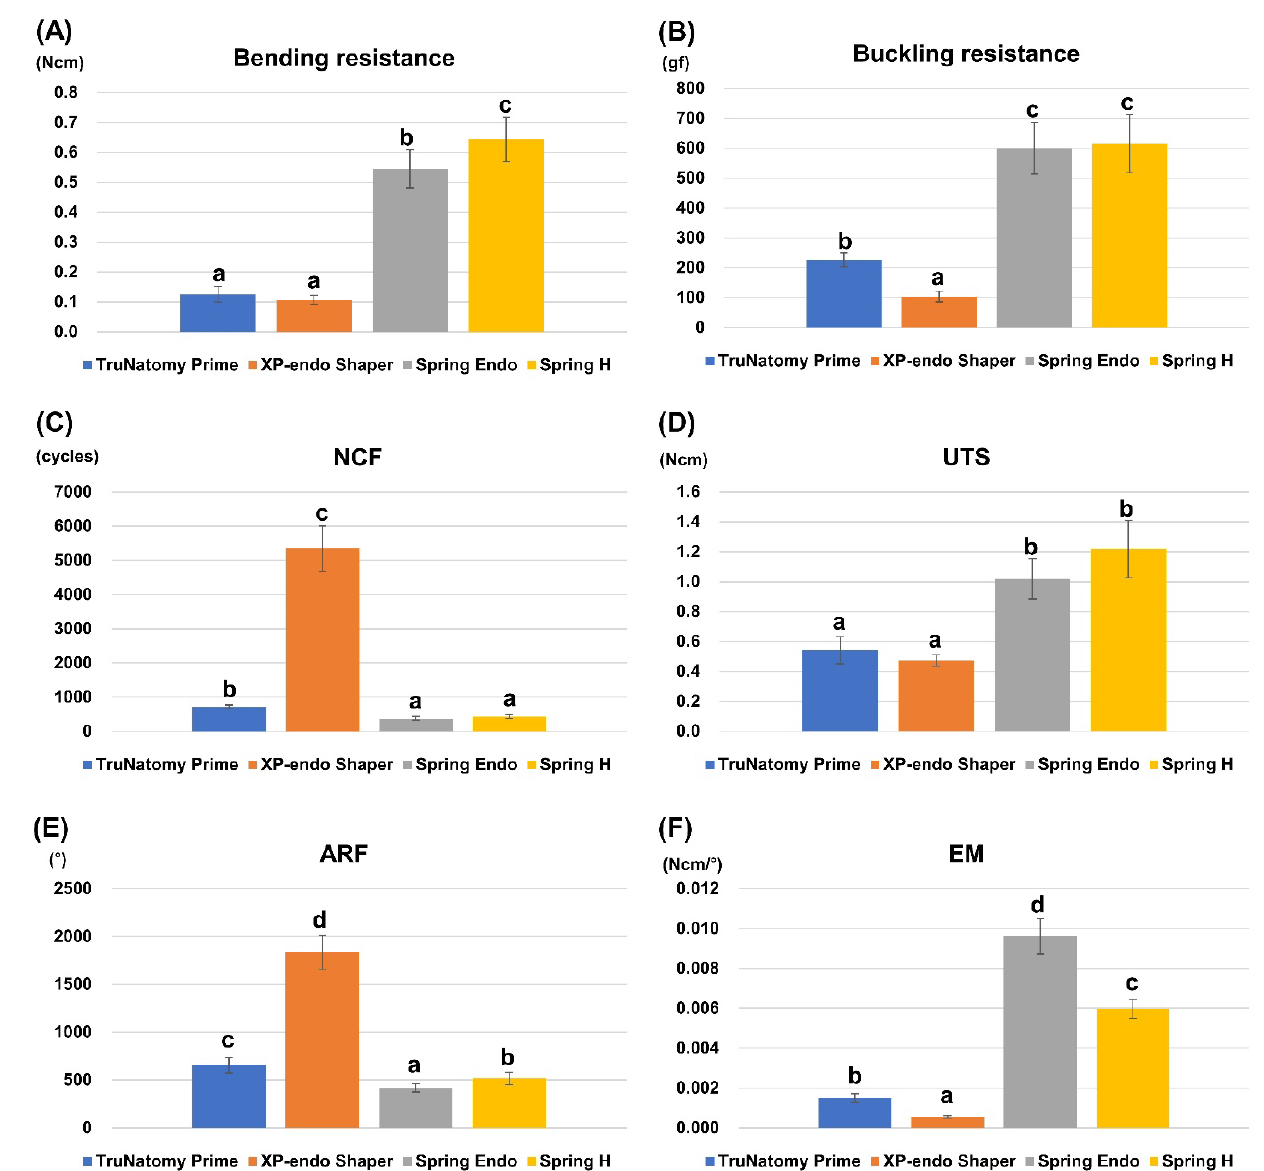
Figure 1. Mechanical test results of TruNatomy Prime, XP-endo Shaper, Spring Endo, and Spring H files. Different lowercase letter indicates statistically significant differences between files. Bending resistance ( A ), buckling resistance ( B ), NCF from cyclic fatigue resistance test ( C ), UTS ( D ), ARF ( E ) and EM ( F ) from torsional resistance test.